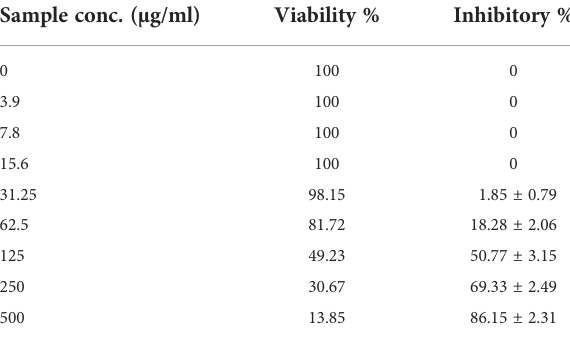
TABLE 3 Inhibitory activity of PoSeNPS against prostate carcinoma cells (PC-3) with IC 50 = 123.51 ± 4.07 µg/mL. Sample conc. (µg/ml)